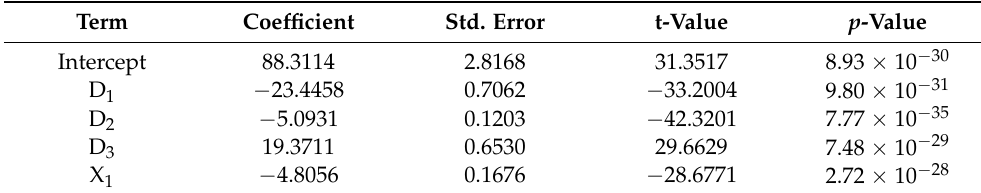
Table 5. Statistical significance of estimated model coefficients.